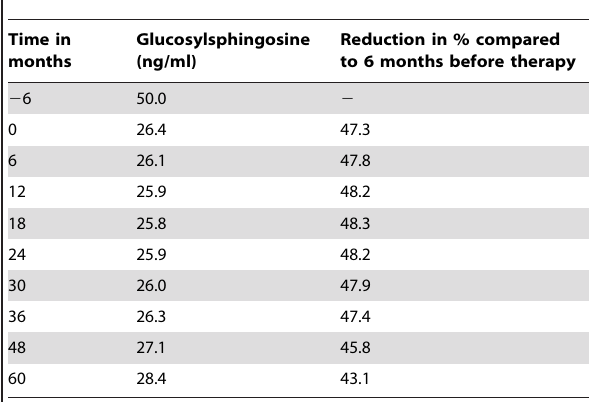
The analysis included all 19 patients for whom values before and after ERT were available, details on the course of Glucosylsphingosine values are shown in Figure 5. Time point zero represents the first value after onset of therapy. The table shows regression based (linear mixed models) predicted values for Glucosylsphingosine and reduction in % compared to 6 months before therapy. To overcome the skewed distribution of measurements Glucosylsphingosine values were logarithmised before regression analysis. Glucosylsphingosine was reduced after onset of ERT. The largest reduction occurred within the first 6 months after starting the ERT therapy. Patients display a reduction of 47.8% after 6 months and of 43.1% after 60 months of therapy.